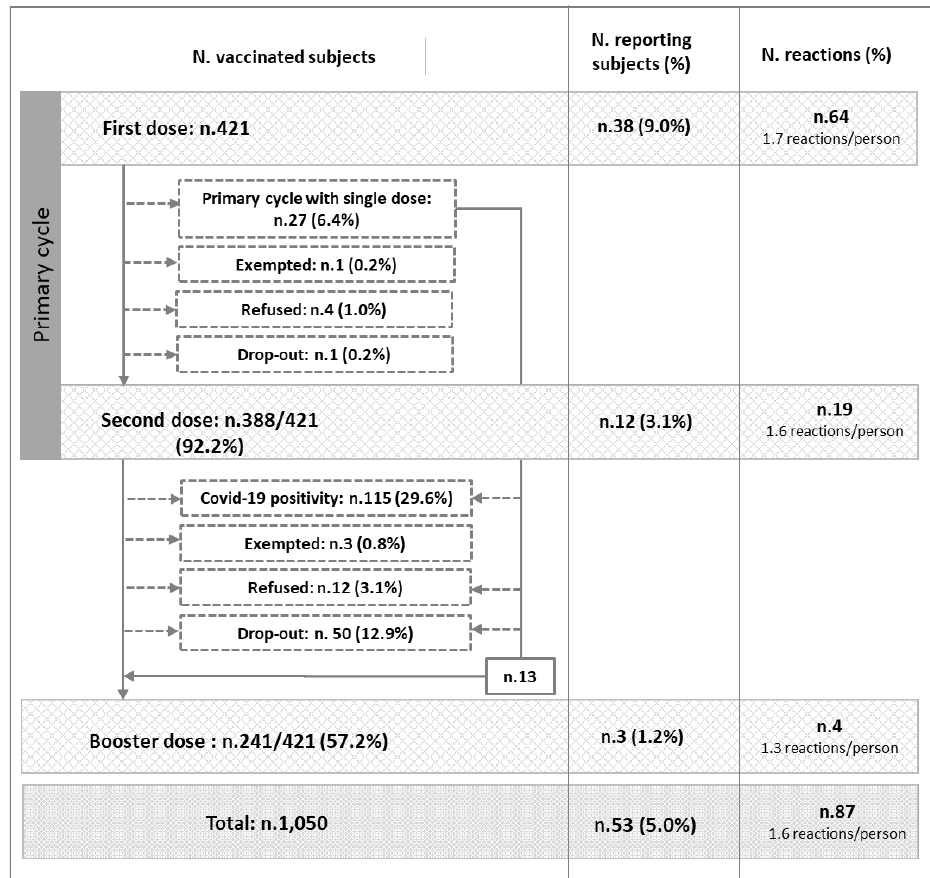
Figure 1. Distributions of subjects vaccinated, numbers of subjects reporting at least one post-vaccination adverse reaction, and numbers of post-vaccination adverse events reported.